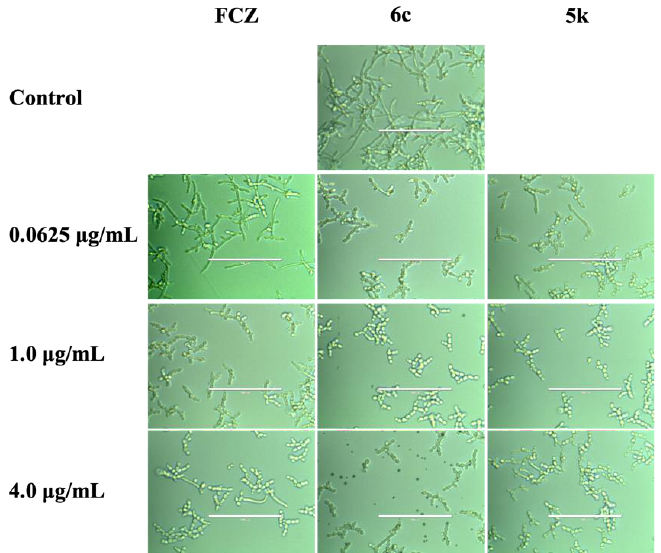
Figure 4. Anti-hyphal effects of different concentrations of compounds 5k and 6c with FCZ (fluconazole) as a positive agent. Exponentially growing C. albicans SC5314 cells were transferred to hypha-inducing Spider liquid medium. The cellular morphology was photographed after incubation at 37 °C for 3 h. Scale bar = 20 μm.